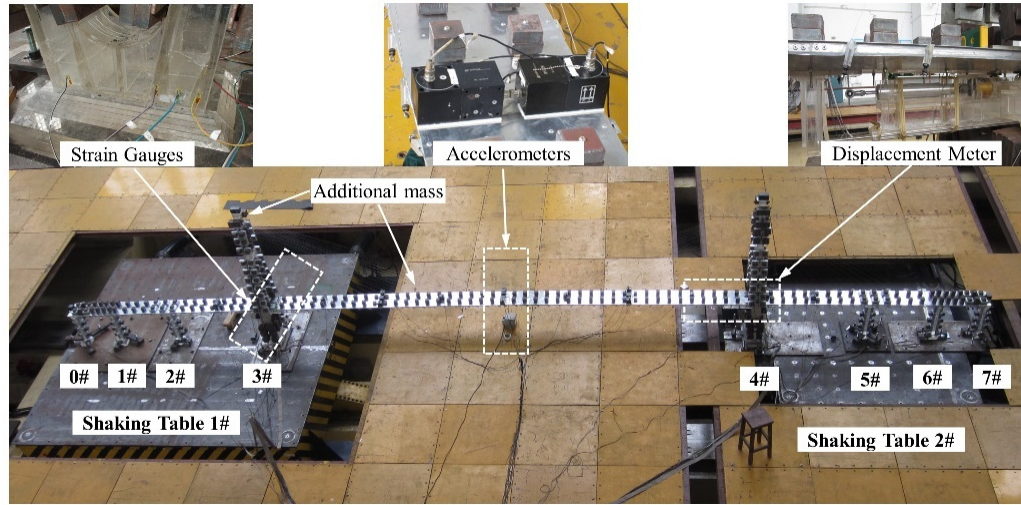
Figure 7. Bridge model assembled on shake tables.